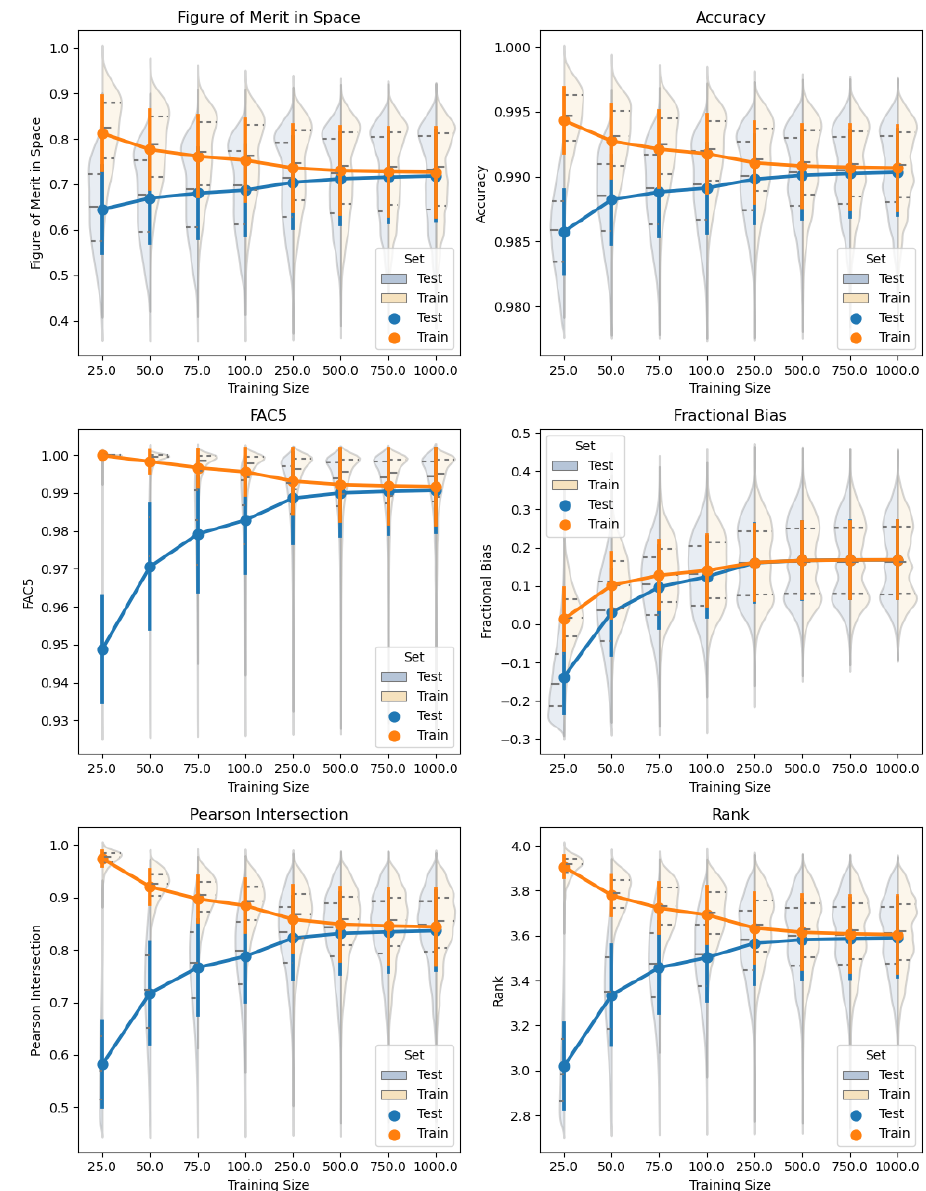
Figure 9. Same as Figure 8, except for the elevated release